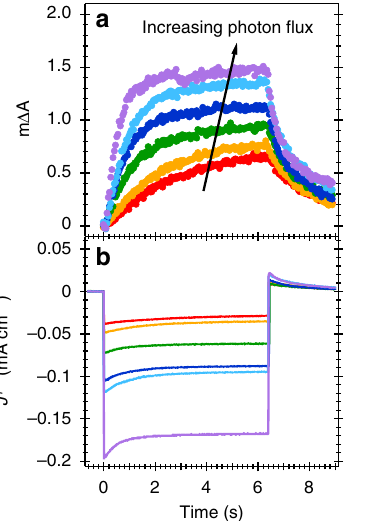
Figure 5 | Absorbance and photocurrent changes under conditions of HER. ( a ) Time-dependent photoinduced absorbance changes of the photocathode upon 365nm light illumination at different photon fluxes (0.5–1.5mWcm (cid:2) 2 ) at a fixed applied potential of 0.1 V RHE and ( b ) the photocurrent measured simultaneously. cannot be used as direct assay of the catalytic behaviour of the RuO x layer in this system.